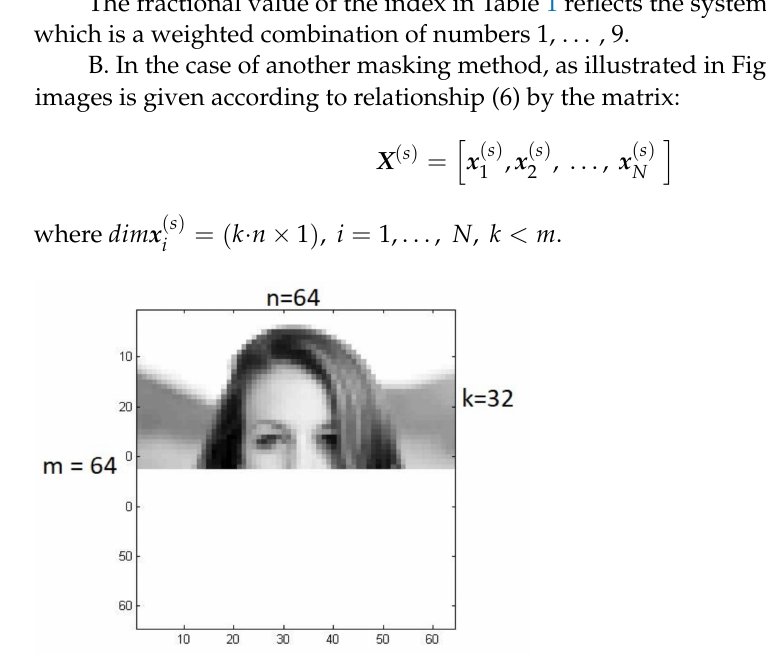
Figure 6. Masked image of the face in Photo Number 9 (Figure 3).